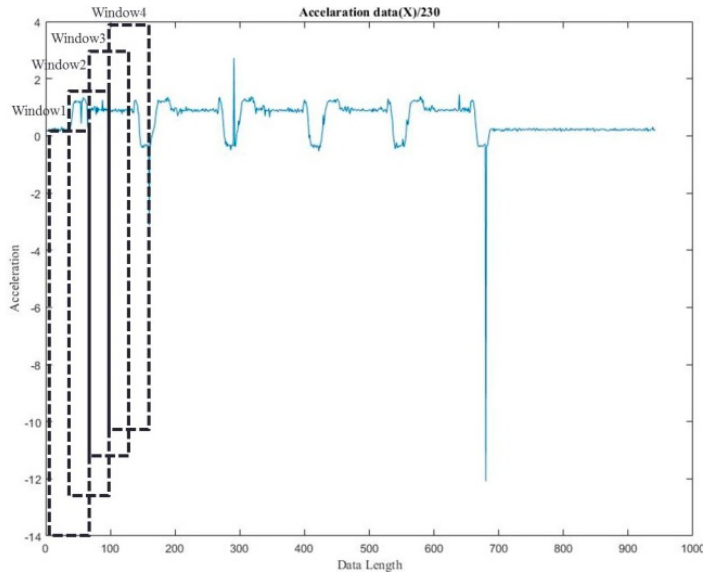
Figure 3. Example of feature extraction using windows.